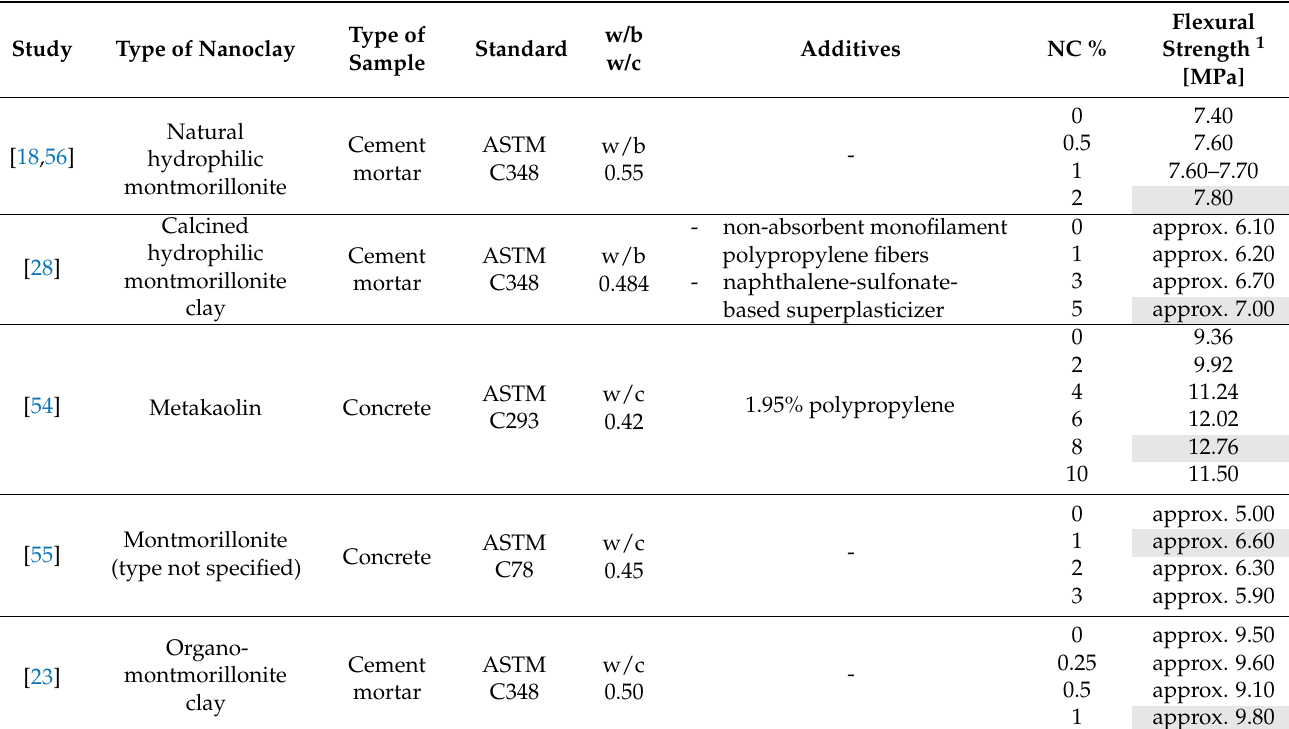
Table 2. Flexural strength values for different nanoclay-cement matrix